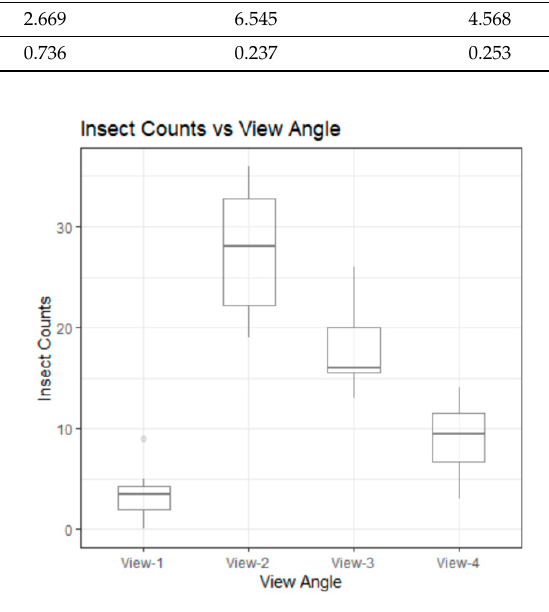
Table 1. A table depicting results from the Feltz–Miller test. All views had significantly di ff erent mean counts as evidenced by the non-overlapping confidence intervals in row 1. Row 2 represents standard deviation and row 3 represents the coe ffi cient of variations. View 1 View 2 View 3 View 4